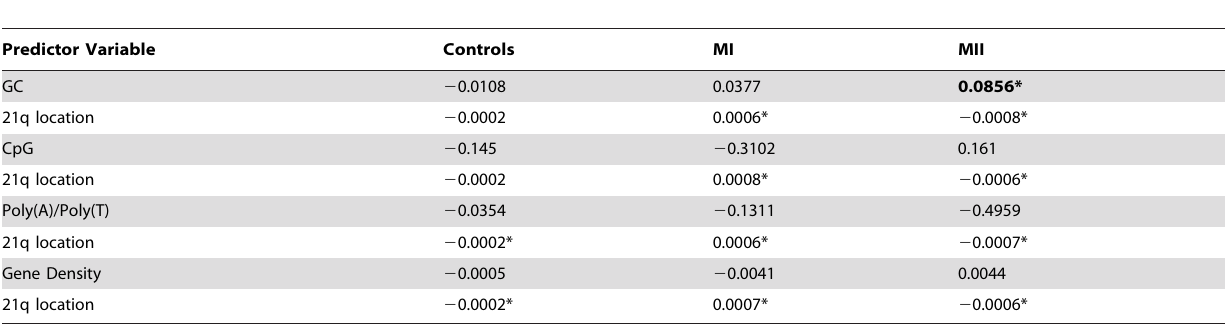
Table 2. Values of slopes/beta coefficients for GC, CpG, PolyAT and gene denisty for single recombinants stratified by meiotic outcome